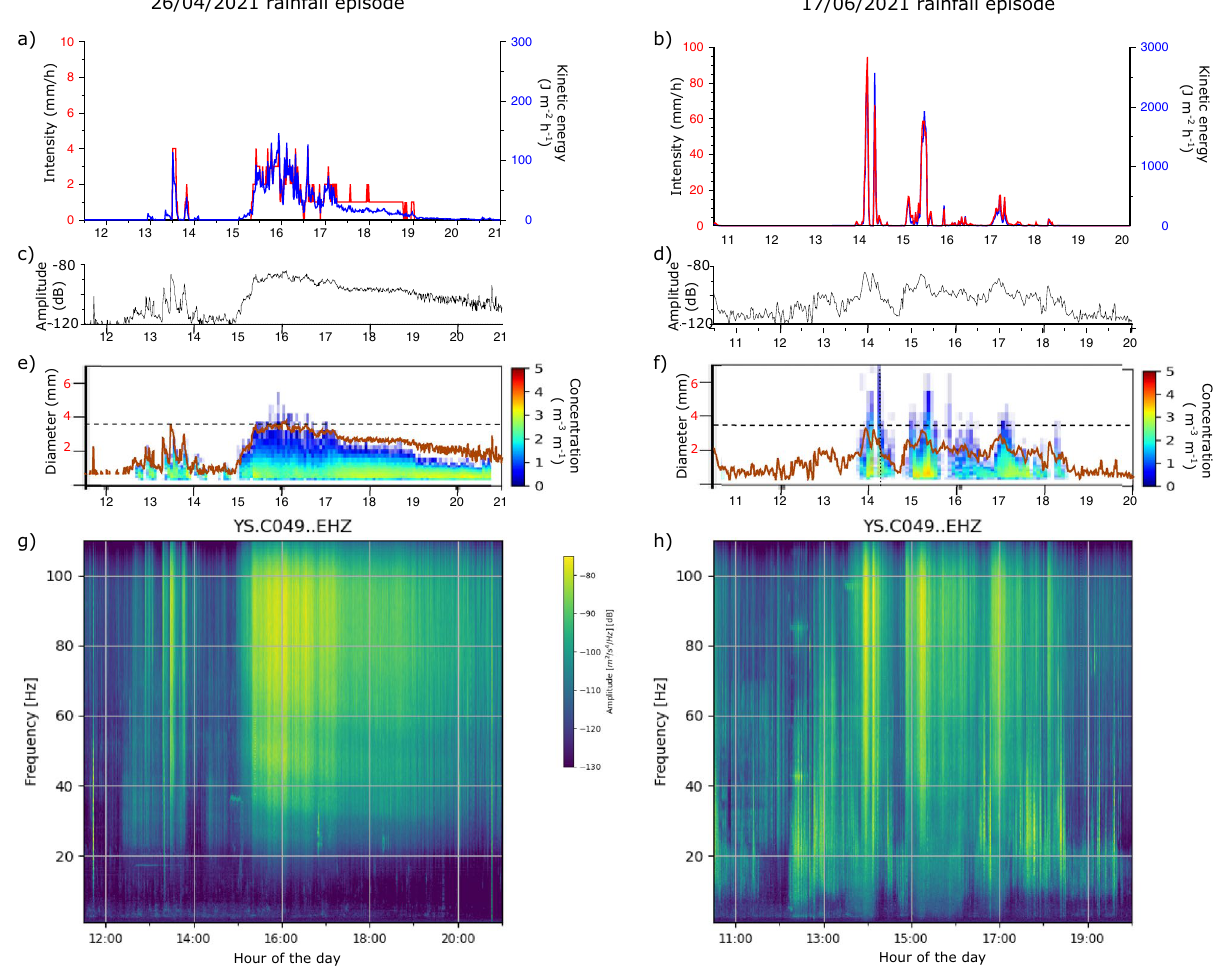
Figure 5. Disdrometer and seismic data at Das (central Cerdanya basin) for the April ( a , c , e , g ) and June ( b , d , f , h ) episodes. ( a , b ) Kinetic energy (red line) and rainfall intensity (blue line) obtained from disdrometer measurements. ( c , d ) Seismic amplitudes for frequencies between 40 and 120 Hz, expressed as dB. ( e , f ) Raindrop diameters and concentrations during each episode. Previously shown seismic amplitudes are repeated here (brown lines) for comparison with the raindrop information. Horizontal dashed lines mark the 3.5 mm diameter threshold level discussed in the text. ( g , h ) Spectrograms calculated using 120 s long